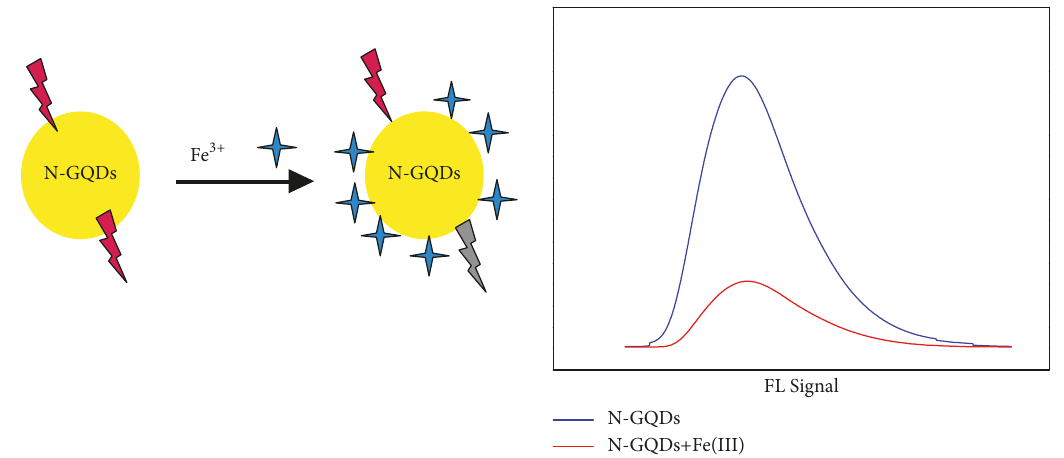
Figure 1: Fluorescence quenching of N-GQDs by iron